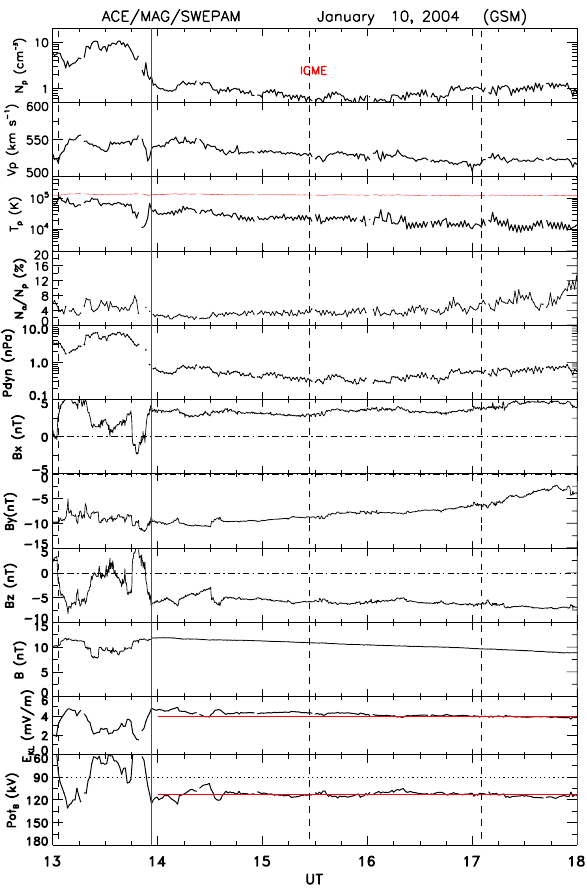
Fig. 6. Interplanetary plasma and magnetic field data obtained from spacecraft ACE during the interval 13:00–18:00UT on 10 Jan- uary 2004: proton density, bulk speed and temperature, the apha- particle-to-proton number density ratios, the dynamic pressure, the components of the magnetic field in GSM coordinates ( B x , B y , B z ) and the total field strength, the geoeffective interplanetary electric field ( E KL ) and the Boyle potential (Boyle et al., 1997). Southward turning of the magnetic field at 13:05UT is marked by the first verti- cal guideline. The vertical dashed lines at 15:27 and 17:05UT mark the times of F15 passes across flow channel FC 1 in the prenoon sec- tor (approx. 09:00MLT/70 ◦ MLAT), when the ACE to Earth propa- gation delay is taken into account. The first (vertical) red guideline marks the front boundary of the ICME. The second (horizontal) red red line gives the average value of E KL = ( 4 . 0 ± 0 . 6 ) mVm − 1 . The horizontal red line in the bottom panel gives the average value of Boyle potential = (112 . 8 ± 3 .